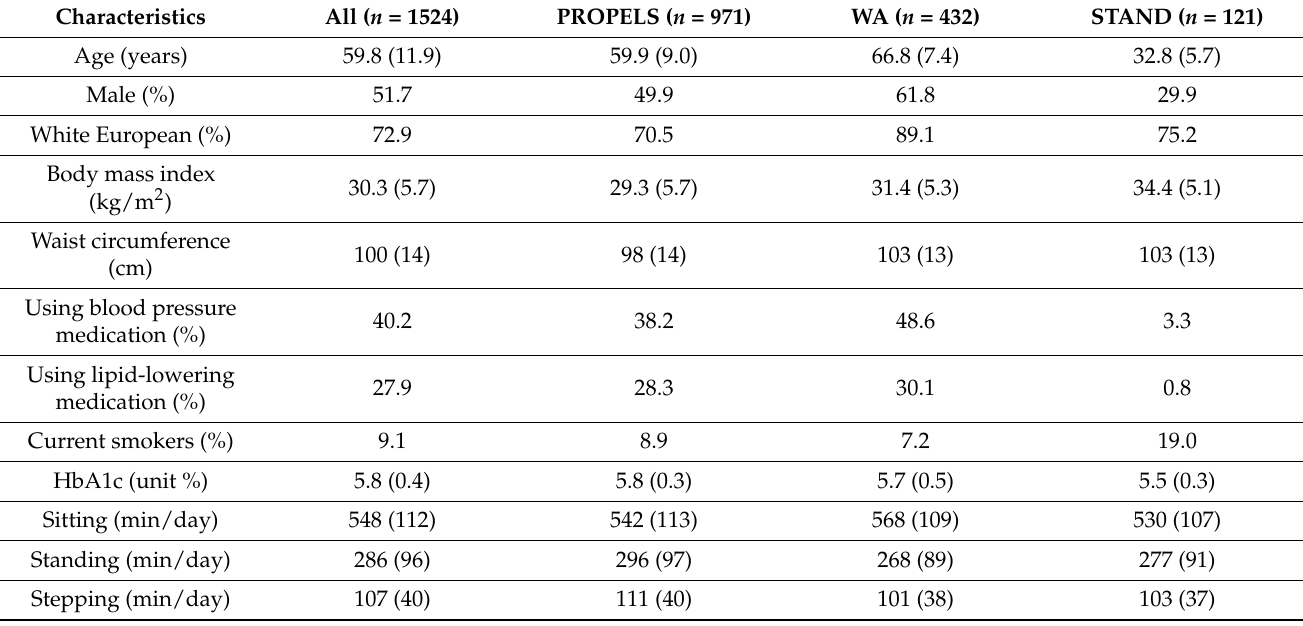
Figure 1. Participant flow diagram. Table 1. Participant